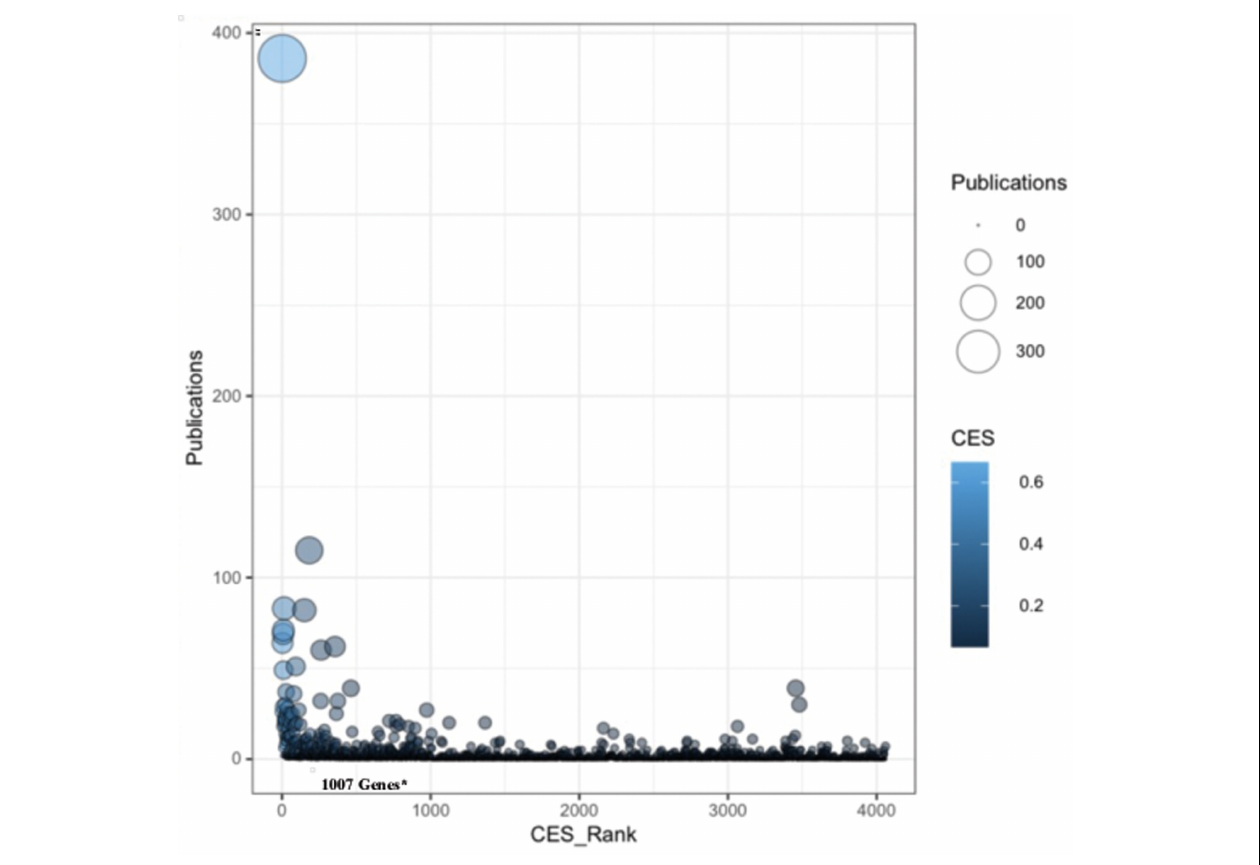
FIGURE 8 | Literature-based mapping of aging and longevity related genes. A gene to literature-based mapping identified the available PubMed literatures evidences for the studied genes to verify their links with human longevity and aging. The X -axis represents the Convergent Evidence Score (CES) based rank (node color) and the Y -axis represents the number of PubMed literature counts (node size) for each gene in our study.